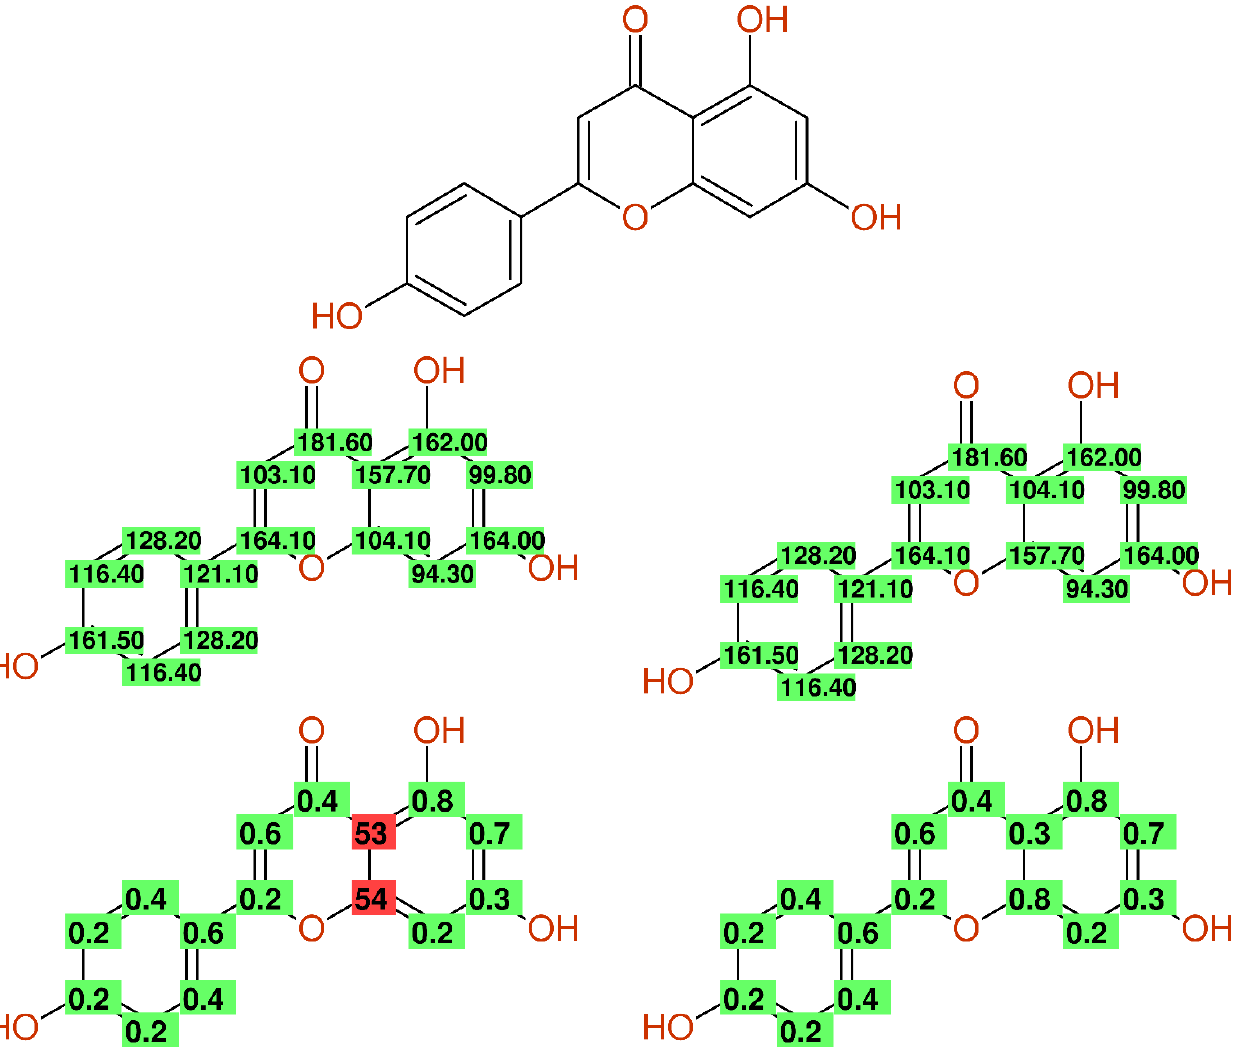
Figure 6. 13 C-NMR data for compound 4 in [41] as published ( left ) and after correction ( right ), together with the differences between the experimental and predicted chemical shift values.